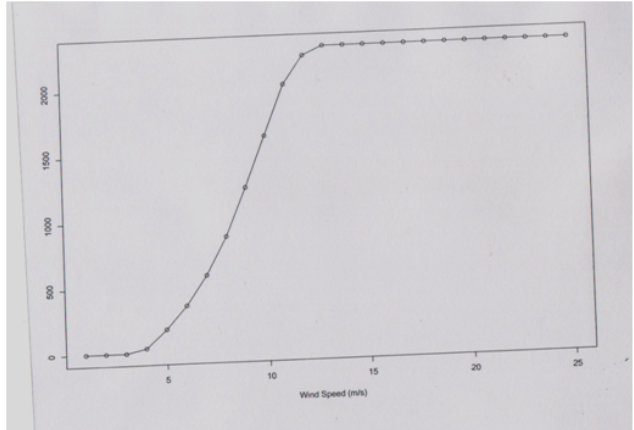
Figure A1. The WT power curve image to be supplied to ‘ img2points() ’ function.